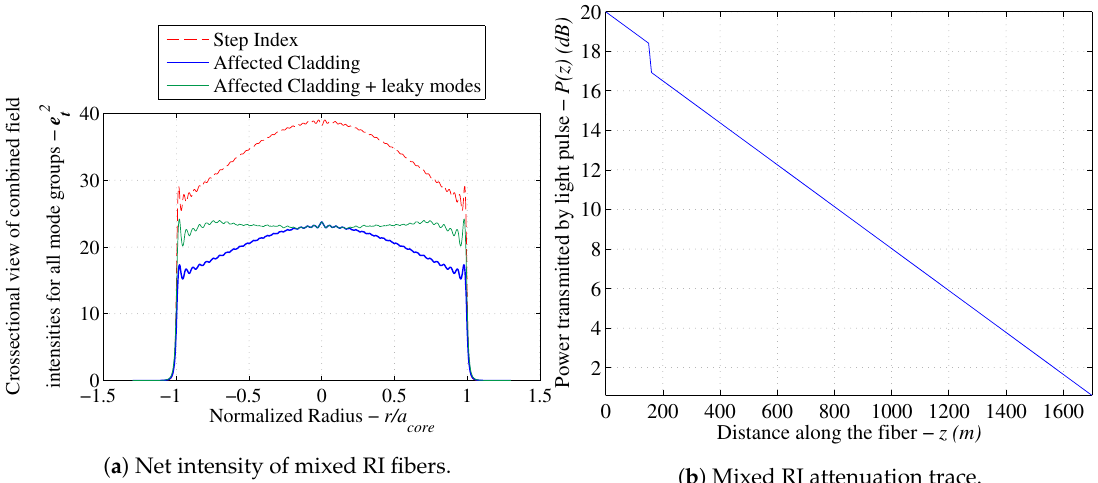
Figure 8. Simulation results for mixed RI fibers showing ( a ) the cumulative intensity distribution and ( b ) the expected attenuation (OTDR) trace for the calculated step drop